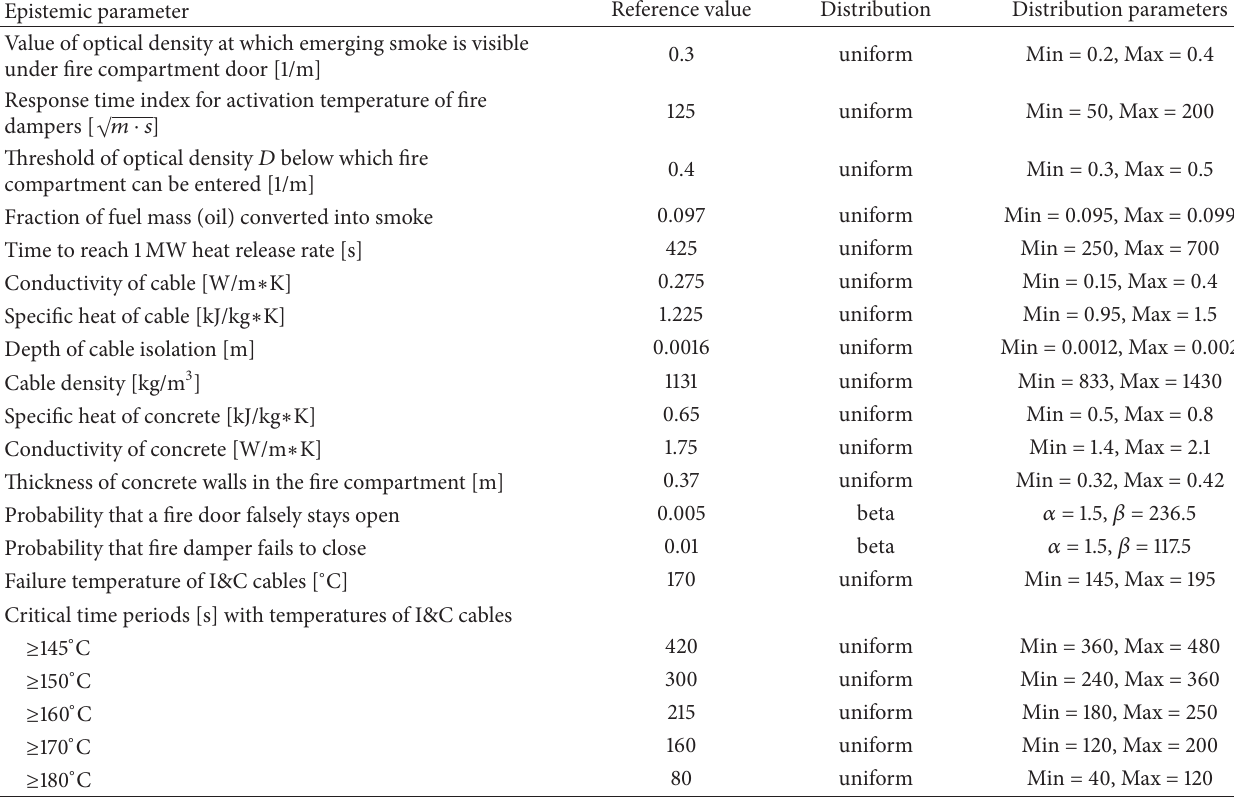
Table 1: Epistemic parameters and specified probability